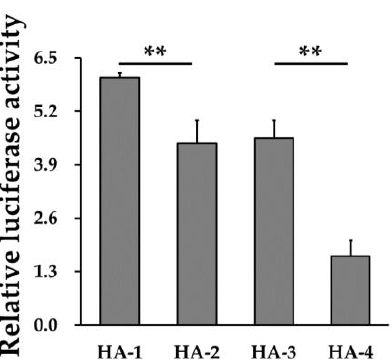
Figure 7. Transcriptional activity of different haplotypes at the binding region of EXOC4 . The relative luciferase activity of EXOC4 with different haplotypes (HA-1 (GC), HA-2 (AC), HA-3 (GT), and HA-4 (GT)). ** indicates p < 0.01. Data are presented as means ± SD. Table 5. Prediction of potential binding sites on − 1781G/A.